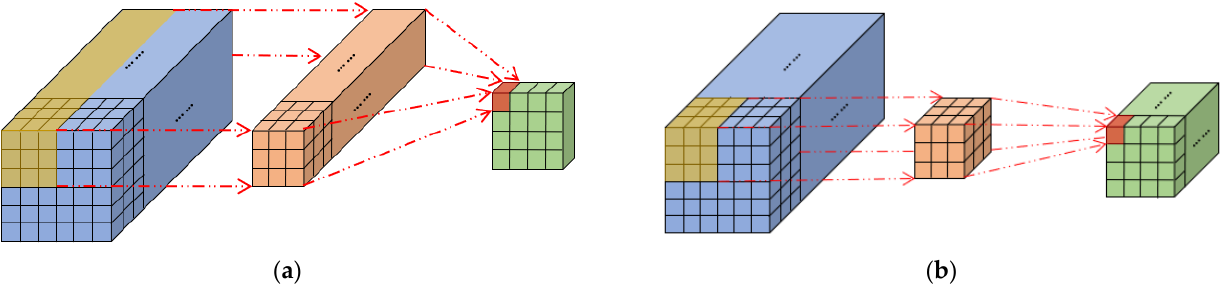
Figure 2. The difference between 3D convolution and 2D convolution. ( a ) Schematic diagram of 2D convolution; ( b ) Schematic diagram of 3D convolution.